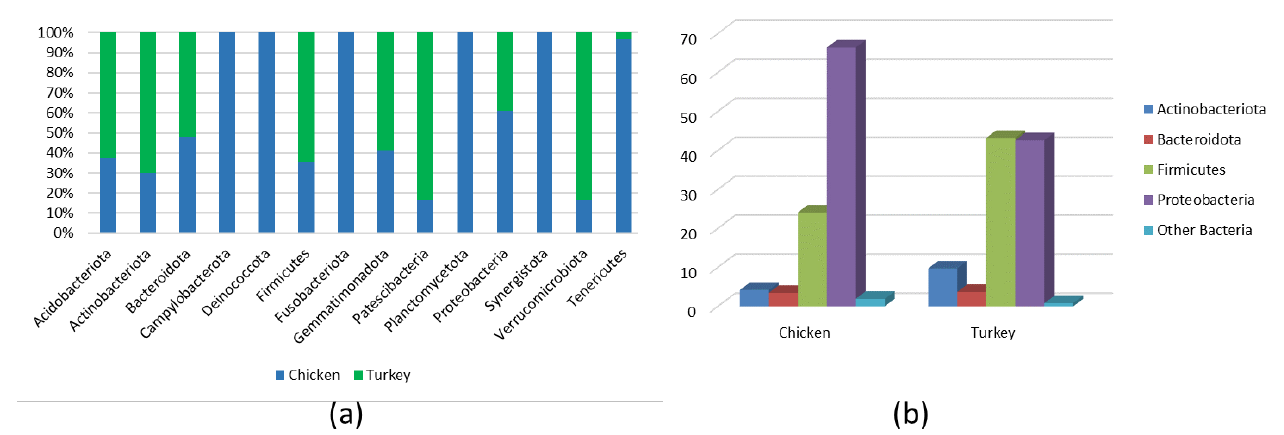
Figure 1. ( a ) All phyla in chicken and turkey URTs. ( b ) Main phyla in chicken and turkey URTs.